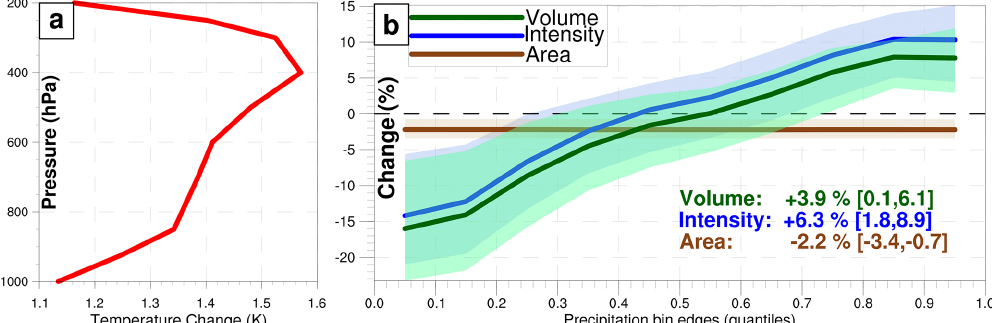
Figure 12. (a) Vertical warming signal and (b) response of event precipitation to warming signal. The warming is based on a subset of 17 CMIP6 models. The x axis in (b) shows precipitation bins which are delineated by quantiles of the precipitation intensity distribution; the changes in area and volume represent the changes associated with precipitation in these bins. Based on the Wilcoxan–Mann–Whitney test, the total changes given within (b) are all statistically significant with at least p < 0 . 02. Shading denotes the 95% confidence intervals based on 1000 bootstrap